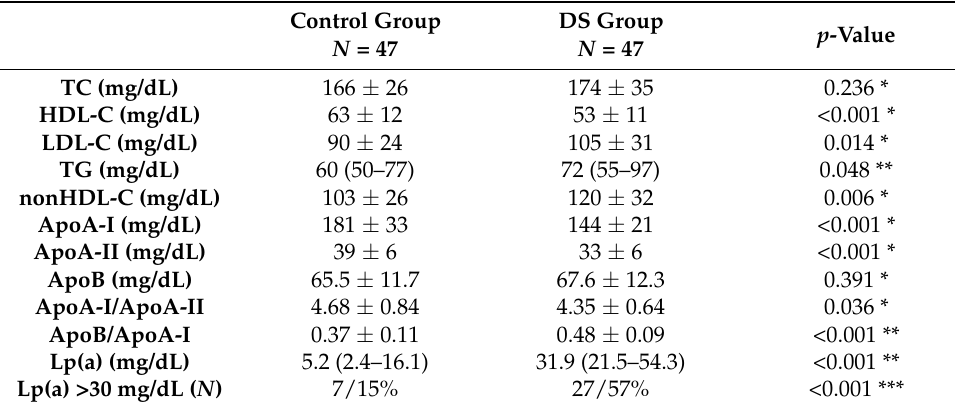
Table 2. Characteristics of the lipid parameters in the study